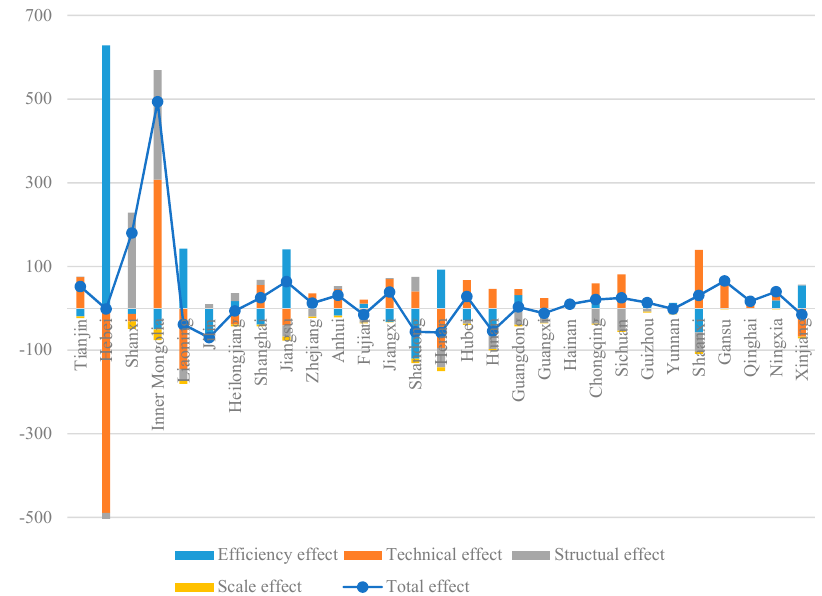
Figure 8. Structural decomposition of input embodied carbon during the period of 2007–2010 (ten thousand tons).